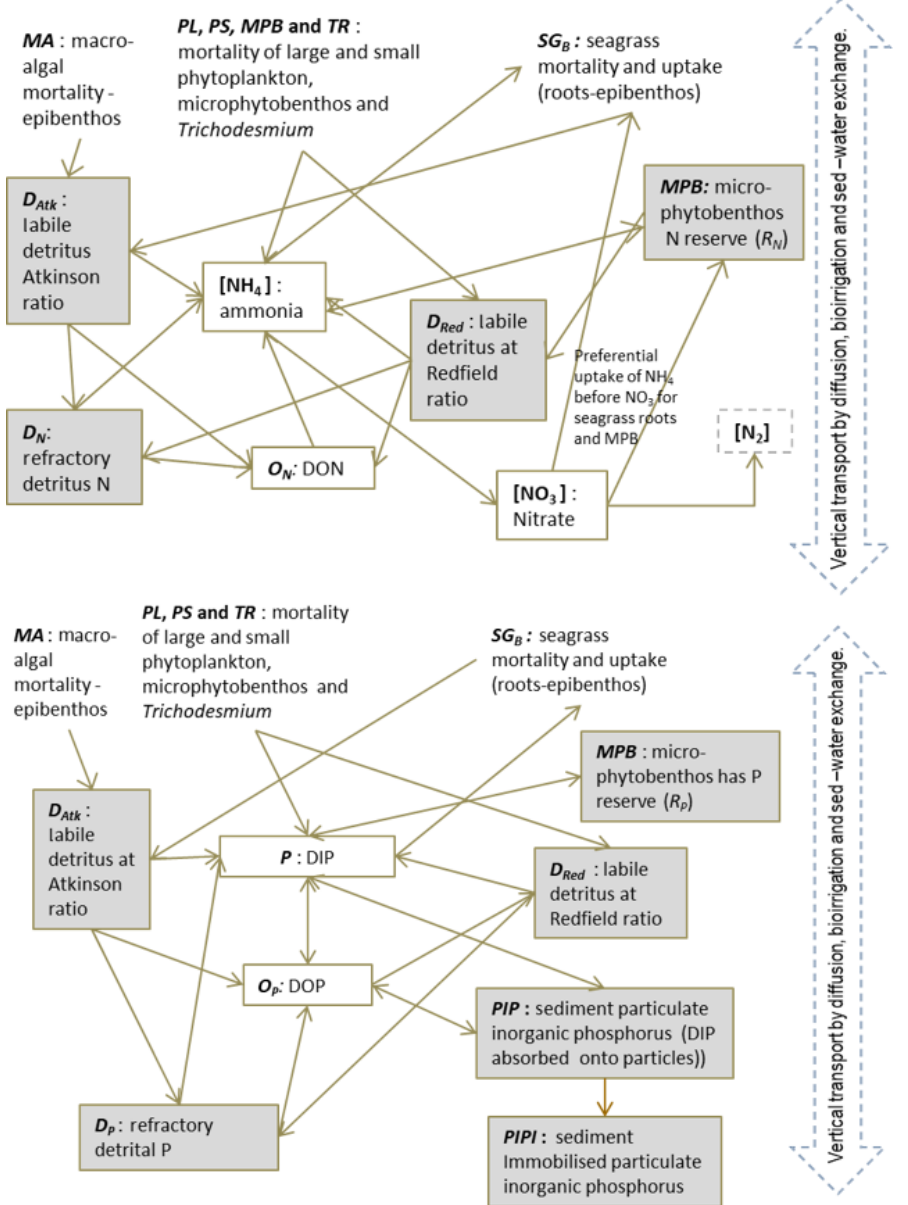
Figure 4. Schematics of sediment nitrogen (top) and phosphorus (bottom) pools and fluxes. Processes represented include phytoplankton mortality, detrital decomposition, denitrification (nitrogen only), phosphorus adsorption (phosphorus only) and microphytobenthic growth. Grey boxes are